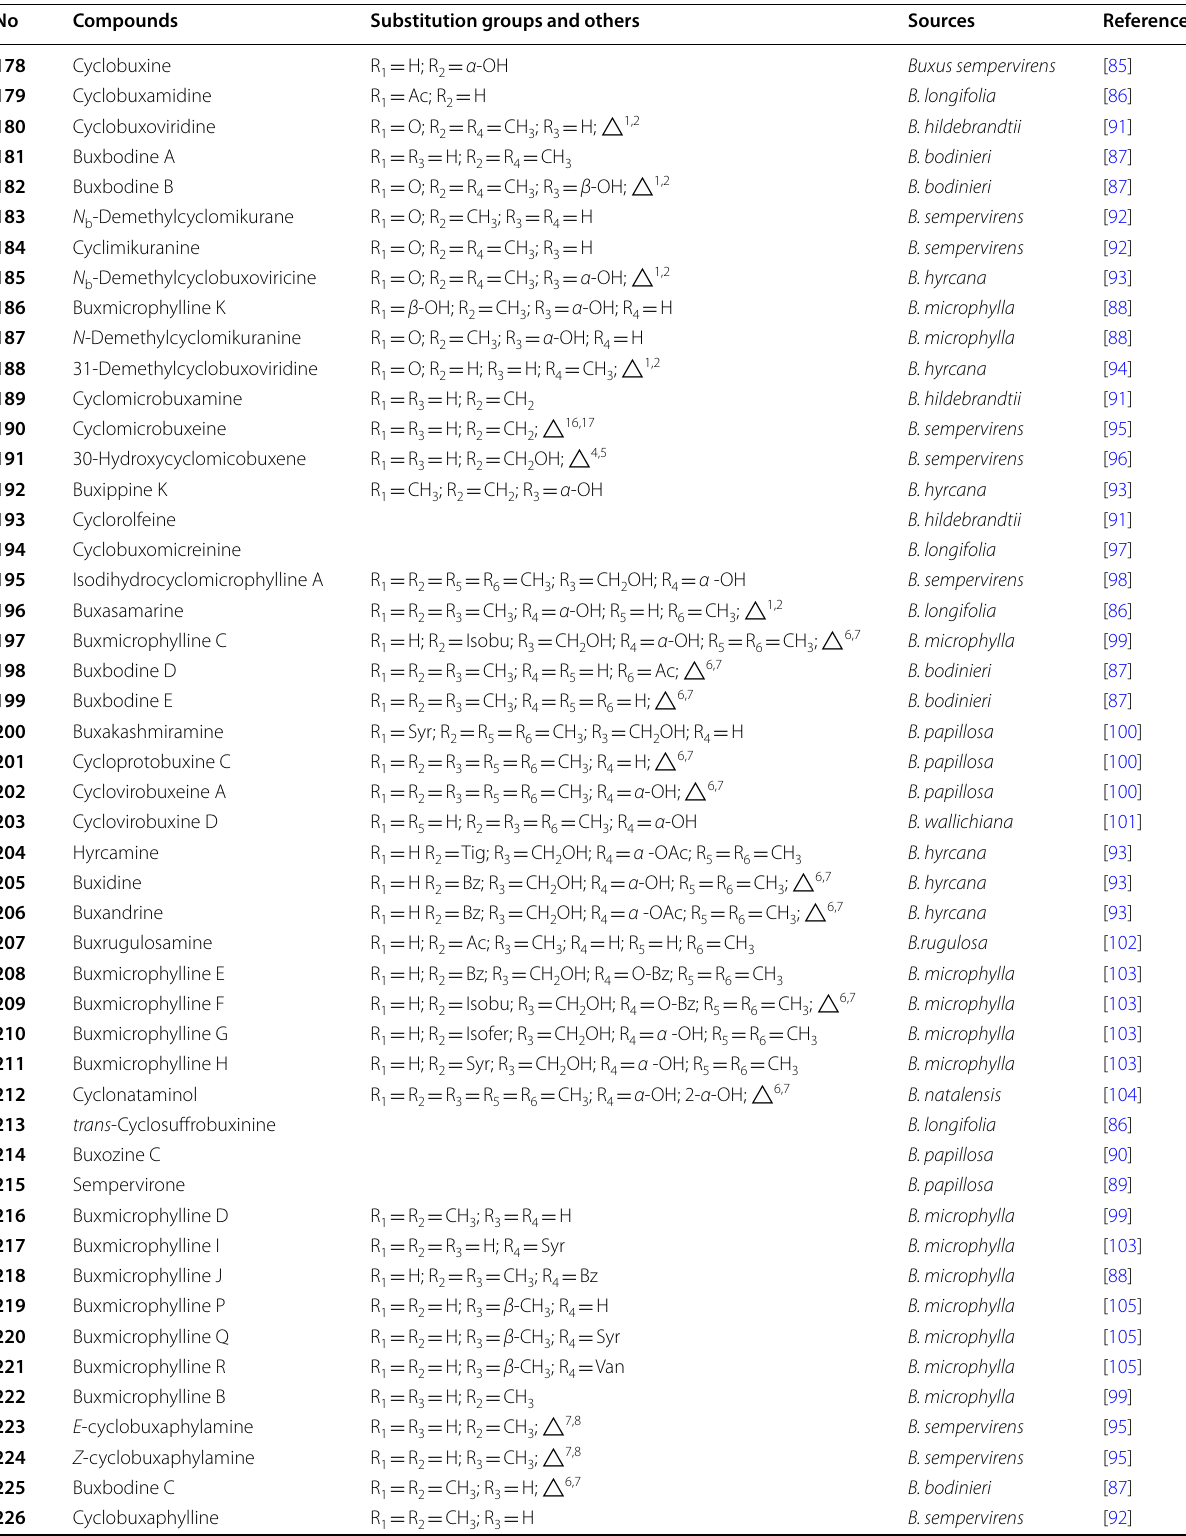
Table 4 Structures and sources of 9 β ,19‑Cyclo‑14 α ‑methylpregnane type steroidal alkaloids 178–227 No